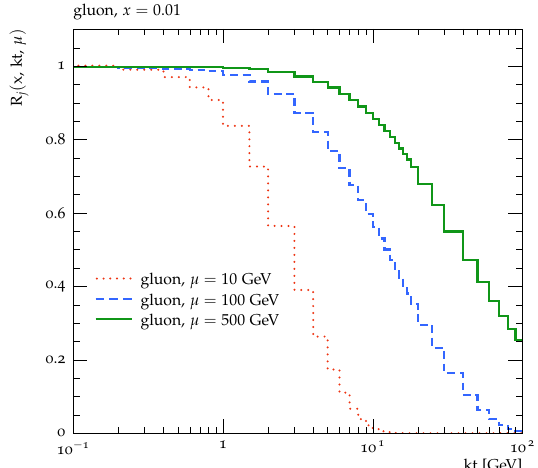
Figure 2 . The | k | spectrum of the integral TMD gluon distribution in eq. (2.3), normalized to k = 0 , for momentum fraction x = 10 − 2 and different values of the evolution scale µ . The PB TMD Set 2 [52] is